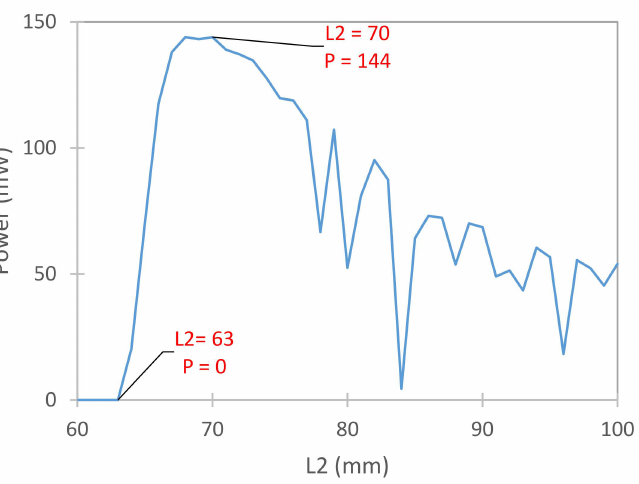
Figure 9. Graph Showing Variation of Power Output with Length Length Between the Fixed End of the Cantilever Beam and the Ending Point of the Piezoelectric Layer L 2